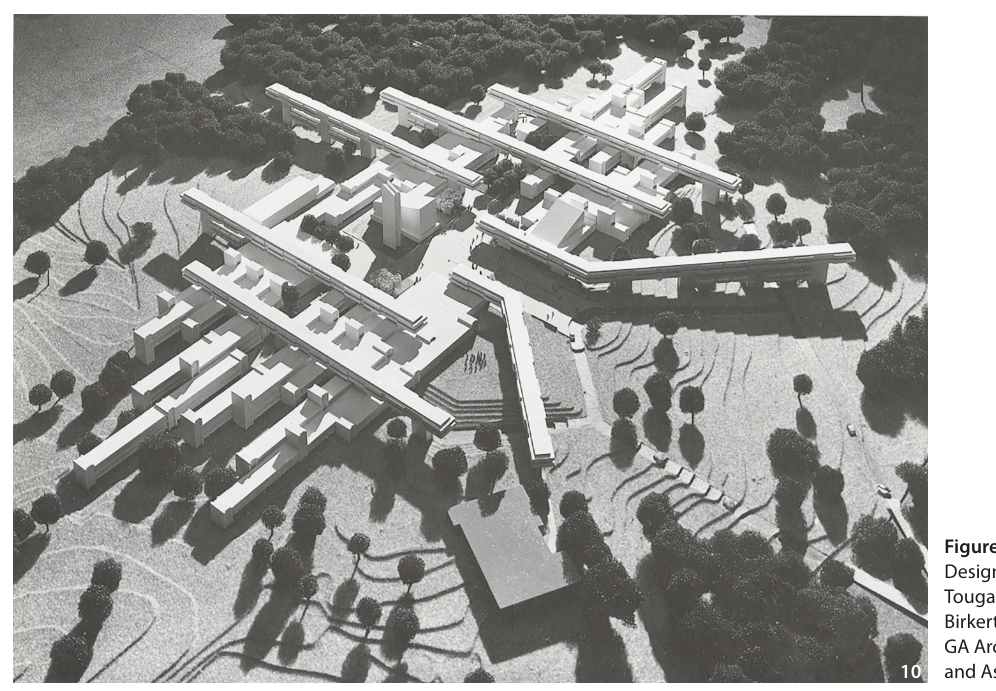
Figure 10 Proposed Campus Design of Tougaloo College, Tougaloo, Mississippi, Gunnar Birkerts, Architect, 1965 (Source: GA Architect, Gunnar Birkerts and